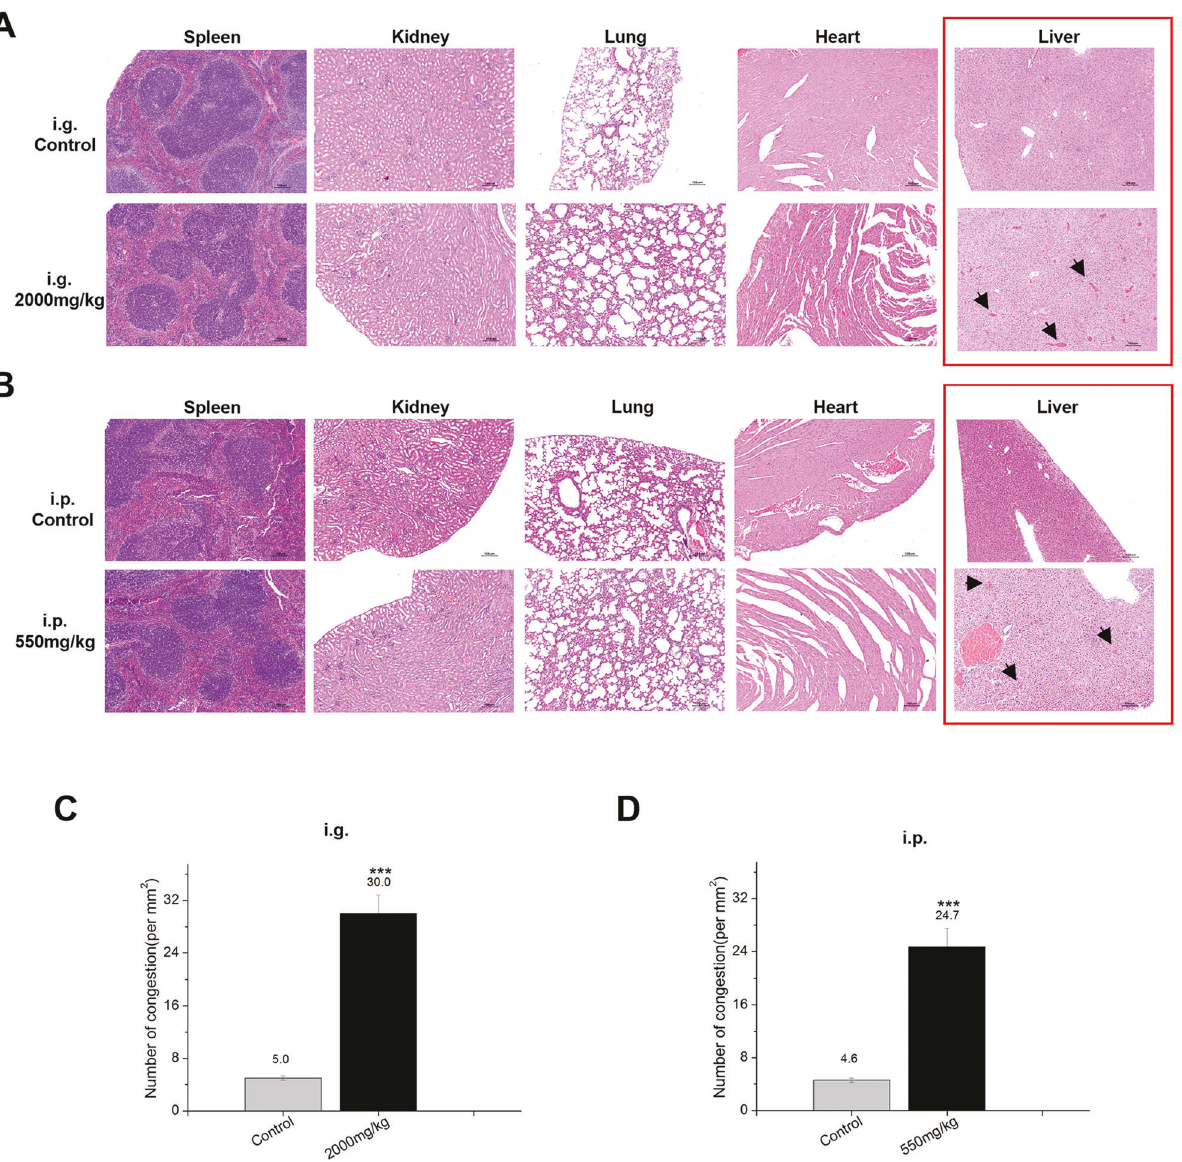
Fig. 6 Histopathological examination after I3C administration. A Spleen, kidney, lung and heart did not show gross pathological change after I3C i.g. administration at 2000 mg/kg. Only in the liver (red square), we observed congestion areas connected to the blood stasis zone. B Spleen, kidney, lung and heart showed no gross pathological change after I3C i.p. administration at 550 mg/kg. We only observed congestion areas in the liver (red square) connected to the blood stasis zone. Congestion was stained with H&E, Black arrows indicate congestion and containing red blood cells. C The number of congestions containing red blood cells in each section after I3C i.g. administration was counted. Results are presented as the average number of congestions per mm 2 as mean ± SD ( n = 25 – 30 fi elds) from three biological replicates and two different observers. D The number of congestions containing red blood cells in each section after I3C i.p. administration was counted. Results are presented as the average number of congestions per mm 2 as mean ± SD ( n = 25 – 30 fi elds) from three biological replicates and two different observers. Statistical signi fi cance was determined by one-way analysis of variance, *** p <